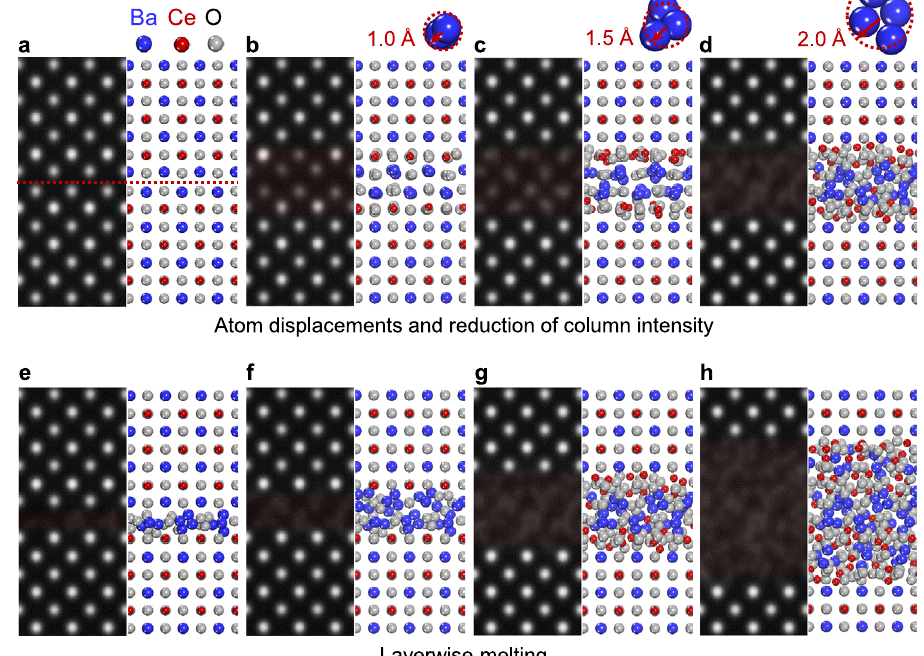
Fig. 7 | STEM image simulations. a − d This series of simulated images and corre- sponding supercells demonstrates how the intensity of atom columns fades and nearlydisappears,whentheaverageatomdisplacementis0( a ),1.0( b ),1.5( c ),and 2Å ( d ). In the fi nal image d , no distinct atomic columns are imaged in the layer where atoms substantially displace from their initial positions. e − h This series of simulated images shows how the atomic-column contrast in STEM images varies